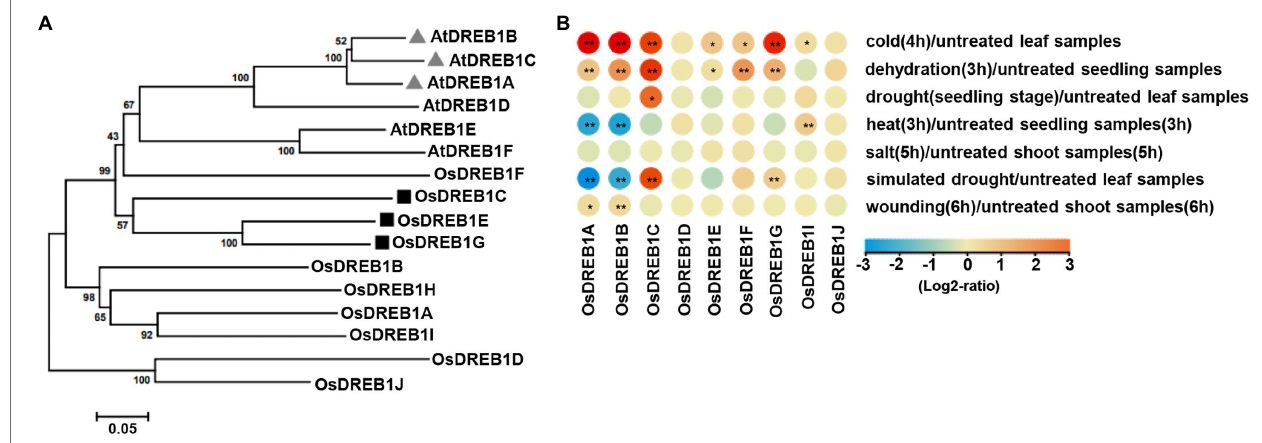
FIGURE 1 | Expression patterns and phylogenetic analyses of OsDREB1 genes in rice. (A) Phylogenetic tree of the OsDREB1 and AtDREB1 proteins. The protein sequences were aligned using ClustatW method, and the neighbor-joining tree with a bootstrap setting of 1,000 was generated using MEGA7.0.14 software. The genes marked with black targets are discussed in this study. The AtDREB1 and OsDREB1 protein sequences were available by TAIR (https://www.arabidopsis.org/) and RiceXPro (https://ricexpro.dna.affrc.go.jp/), respectively. (B) Expression patterns of OsDREB1 genes in response to abiotic stresses. Heat map was plotted via Tbtools. Expression levels are given as log2 ratio values. Expression values are obtained from GENEVESTIGATOR (https://genevestigator.com/). * and ** indicate significant differences compared to no treatment at p < 0.05 and p < 0.01, respectively, by Student’s t